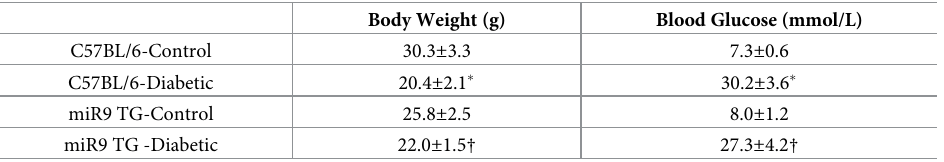
Table 2. Parameters for clinical